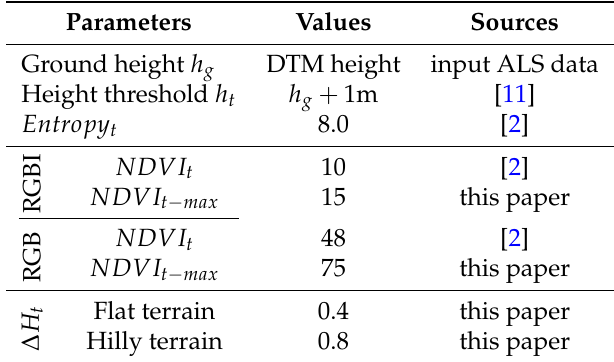
Table 1. Parameters used by the proposed building detection